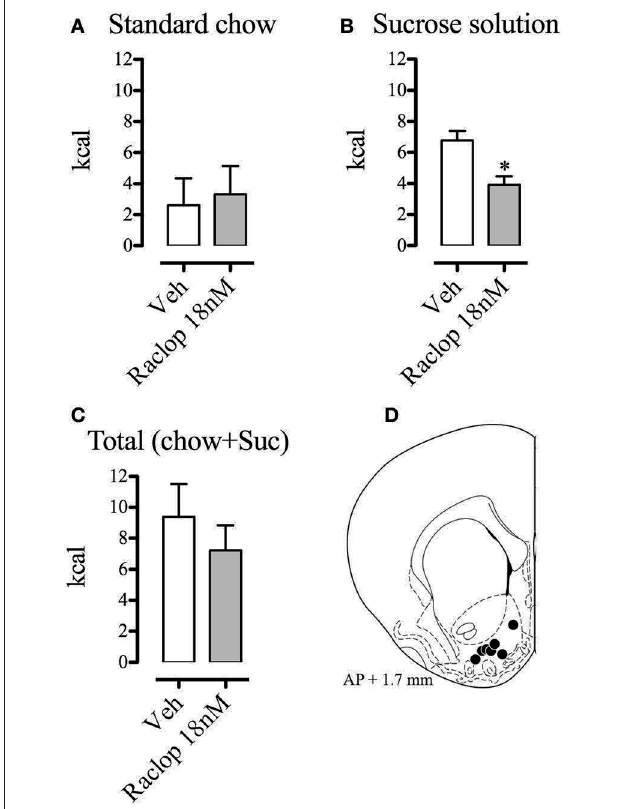
FIGURE 9 | Effects of intra-NAcS injection of raclopride (18nM) on energy intake from chow (A) , from the sucrose solution (B) , and total energy intake (chow + sucrose) (C) , after the 28 days of intermittent exposition to the sucrose solution ( n = 8 each group). Food and sucrose solution intake were measured in grams during a 2-h period, converted to kcal and expressed as means ± S.E.M. Schematic illustration of the injection sites in the NAcS (black circles) (Paxinos and Watson, 1998) (D) . Veh, vehicle; Raclop, raclopride. * p <